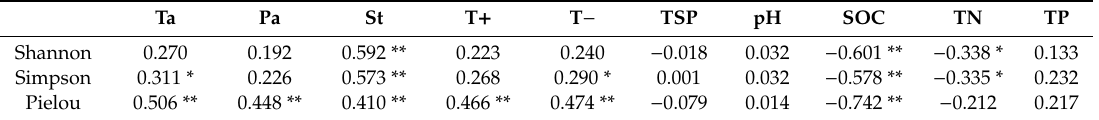
Table 3. Pearson correlation coe ffi cients for EM fungal diversity and climate factor / soil properties. Ta Pa St T + T − TSP pH SOC Shannon